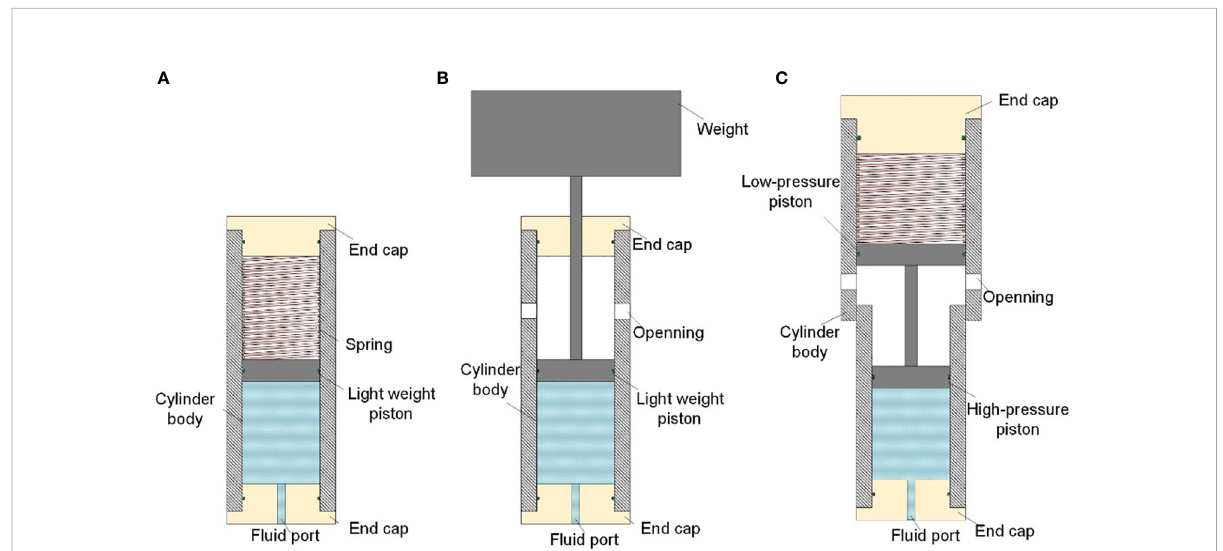
FIGURE 12 New structures of accumulators (A) : Spring loaded accumulator; (B) : Improved spring-loaded accumulator; (C) weight-loaded accumulator.